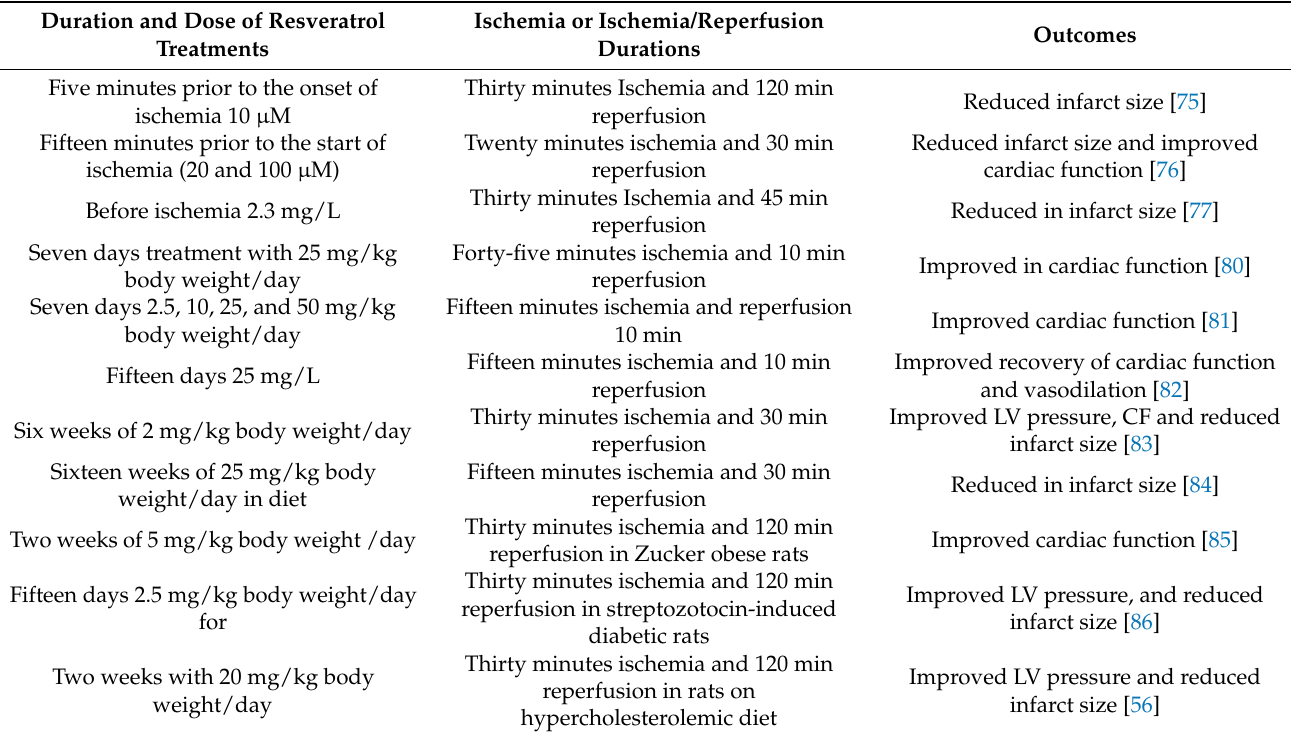
Table 1. Ex vivo evidence of resveratrol mediated cardioprotection in ischemia and ischemia/reperfusion. Duration and Dose of Resveratrol Ischemia or Ischemia/Reperfusion Treatments Durations